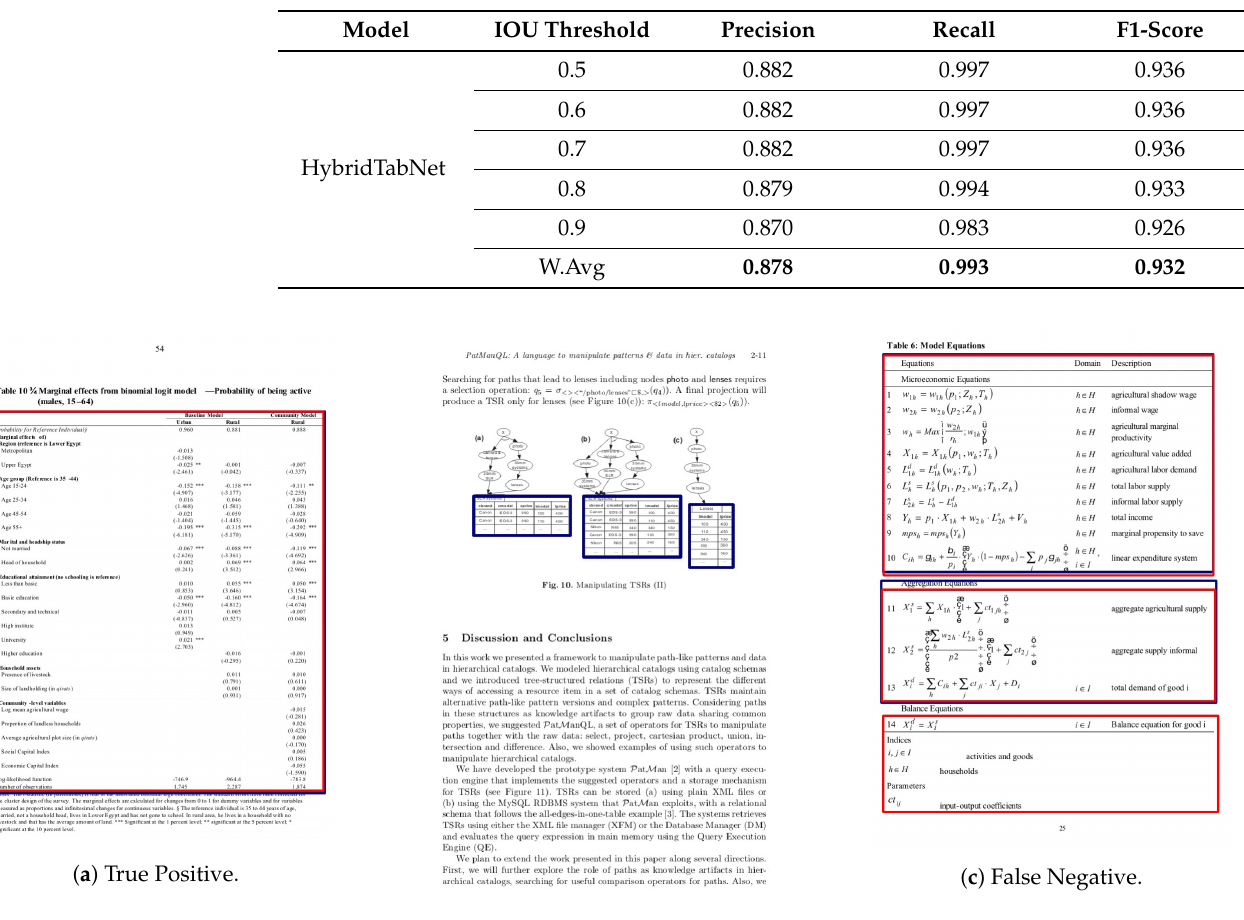
Table 2. HybridTabNet results ICDAR-17 POD results with a deformable ResNeXt-101 back- bone. W.Avg denotes weighted-average of the respective measure on the IoU threshold.